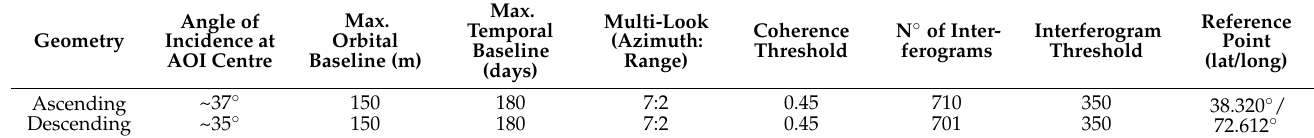
Table 1. InSAR processing